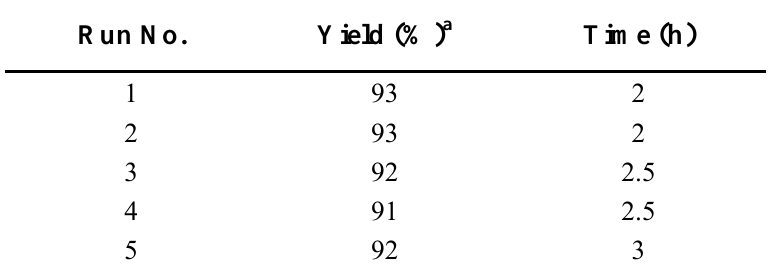
Table 3. Reusability of H PW in the reaction of 2-amino benzophenone ( 1 ), and ethyl 3 acetoacetate ( 2 ) under solvent-free